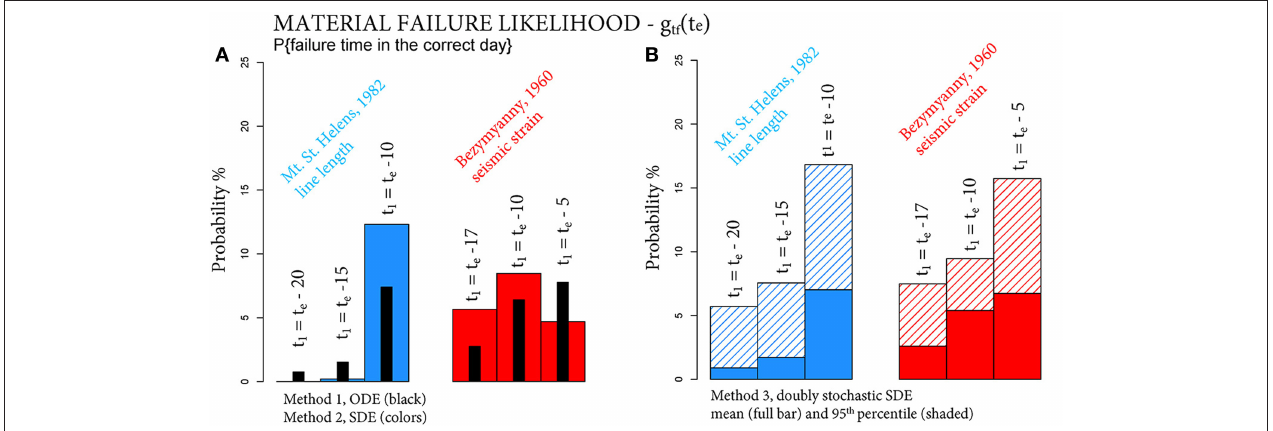
FIGURE 11 | Column plots of the likelihood g t ( t e ) in two forecasting examples, on three different time windows. In (A) the black bars assume Method 1, the colored f bars Method 2. (B) Assumes Method 3, and the full bars are the mean values, and the shaded bars are the 95th percentile values of the